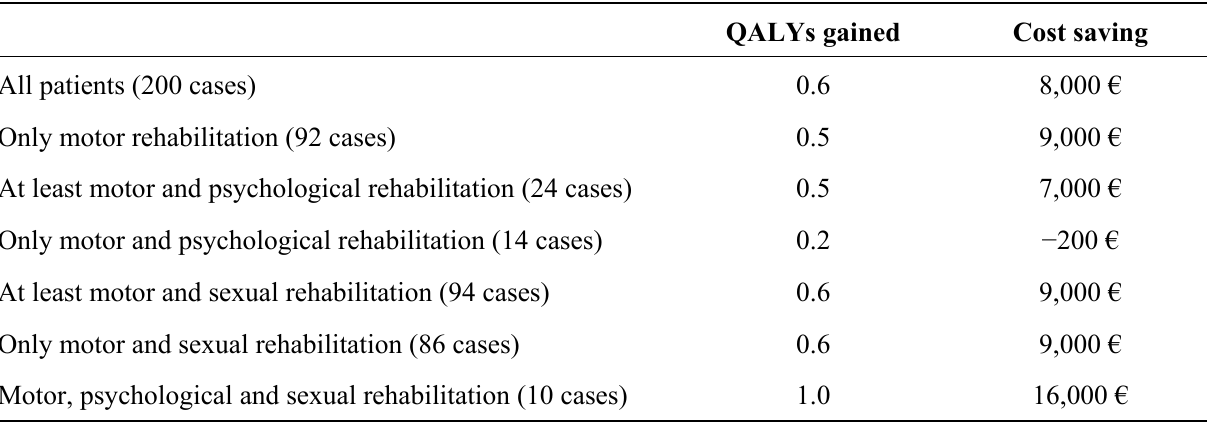
Table 8. QALYs gained and cost savings under different sorts of cardiac